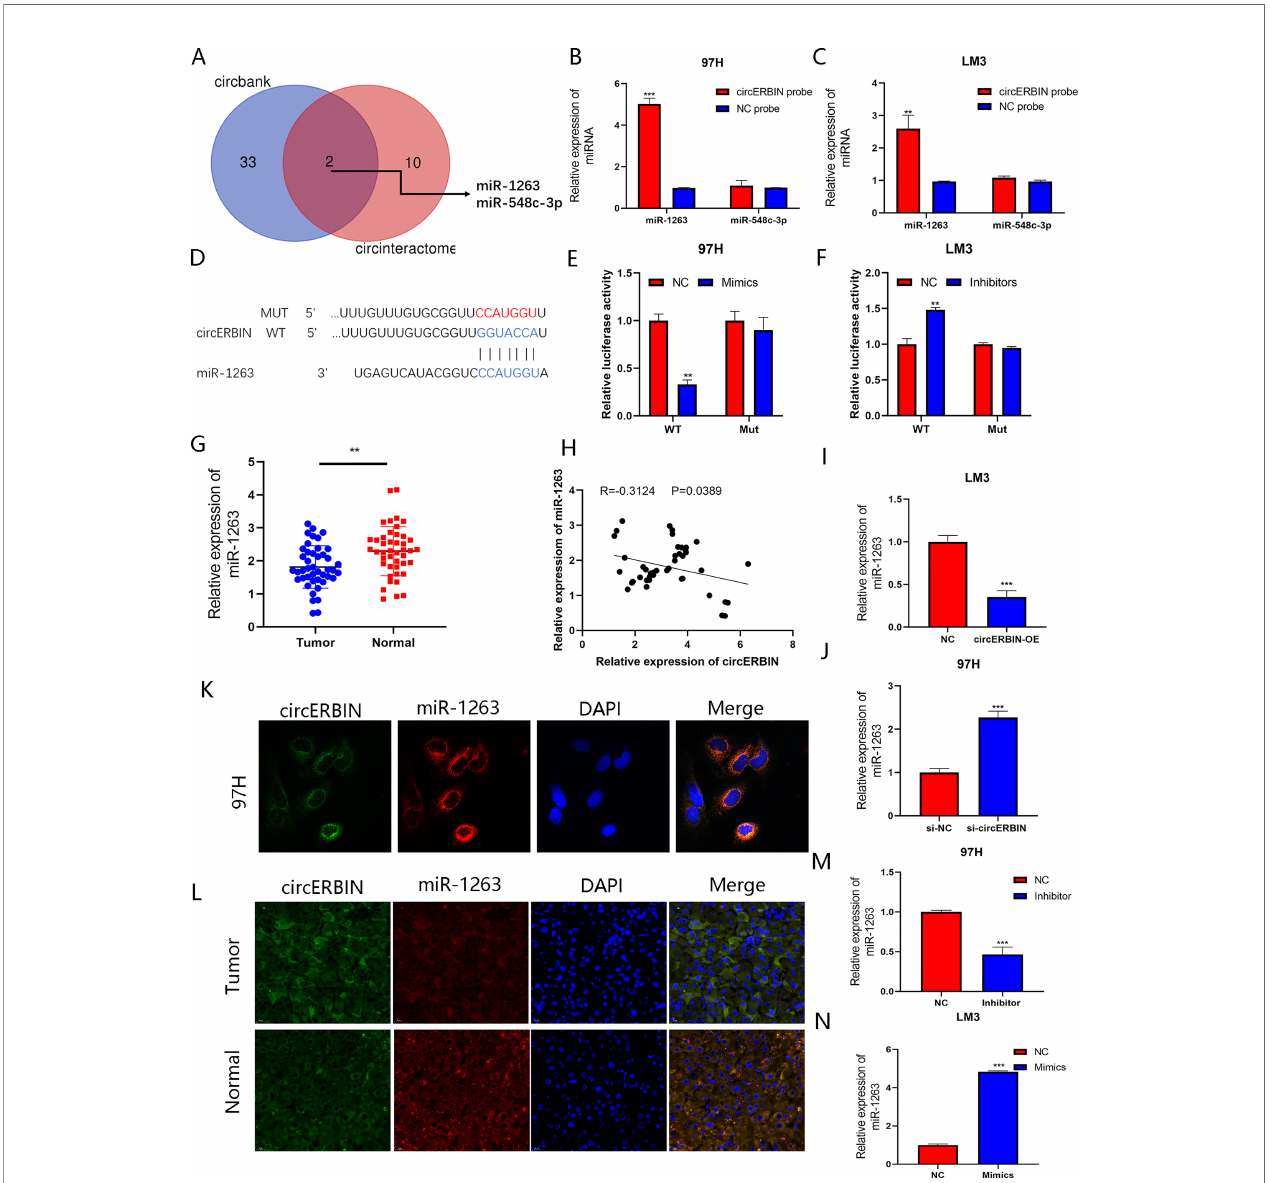
FIGURE 4 | miR-1263 is sponged by circERBIN. (A) Schematic illustration exhibiting overlapping of the target miRNAs of circERBIN as predicted by the circBank and CircInteractome database. (B, C) The relative abundances of two miRNA candidates in 97H and LM3 lysates with circERBIN or oligonucleotide probes were examined by qRT-PCR. (D) Schematic illustration of the sequence of WT and MUT circERBIN at the miR-1263 binding site. (E, F) The effects of miR-1263 mimics, an inhibitor, and NC on luciferase activity were detected in HCC cells transfected with luciferase reporter plasmids. (G) Relative miR-1263 expression in 44 pairs of fresh frozen HCC tissues and matched normal liver tissues. (H) An obvious negative correlation between the levels of circERBIN and miR-1263 in 44 pairs of fresh frozen HCC tissues and matched normal liver tissues as determined by Pearson correlation analysis. (I, J) The relative levels of miR-1263 in 97H and LM3 cell lines transfected with si-circERBIN, circERBIN, or NC as detected by qRT-PCR. (K) Co-localization of circERBIIN and miR-1263 in HCC cells as detected with the FISH assay. Scale bar, 10 m m. (L) FISH results showing co-localization of circERBIIN and miR-1263 in HCC and para-cancerous tissues from patients. Scale bar, 25 m m. (M, N) Relative miR-1263 expression in transfected 97H and LM3 cells. (** p < 0.01, *** p <